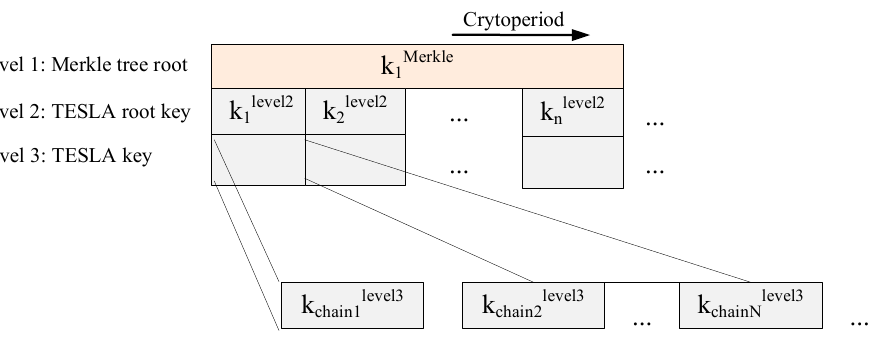
Figure 9. Three-level scheme based on the Merkle tree.